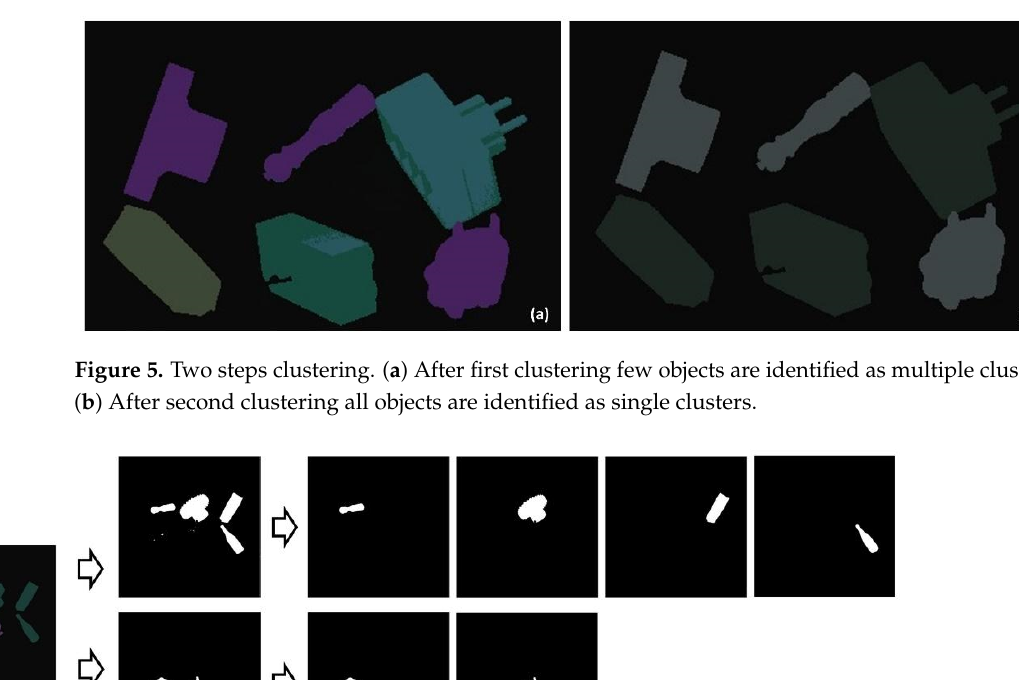
Figure 5. Two steps clustering. ( a ) After first clustering few objects are identified as multiple clus- ters; ( b ) After second clustering all objects are identified as single clusters.